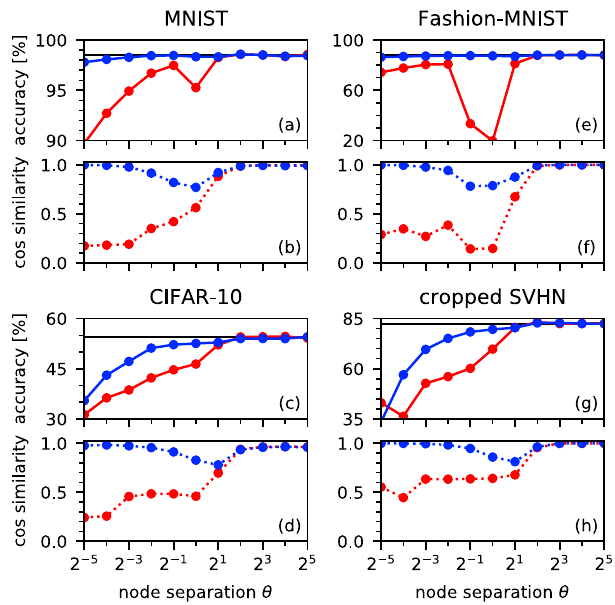
Fig. 4 Fit-DNN performance for classi fi cation and denoising tasks; dependence on the node separation θ . Shown are accuracies of the classi fi cation tasks by employing the back-propagation algorithm taking the local coupling into consideration (blue points), and neglecting them (red points); ( a , c , e , and g ). The accuracy obtained in the map limit case θ → ∞ is shown by the horizontal black line (this corresponds to the classical sparse multilayer perceptron). Lower panels b , d , f , and h show the cosine similarities between the numerically computed approximation of the exact gradient and the gradient obtained by back-propagation with (blue points) or without (red) local